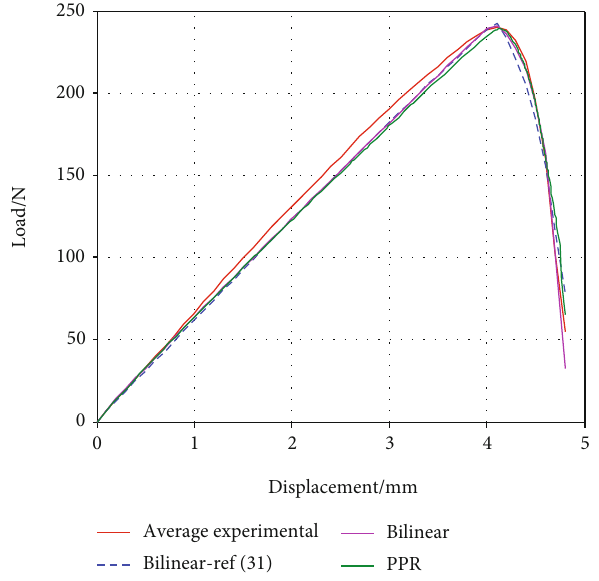
Figure 17: Average experimental and numerical load-displacement curves for SLJ